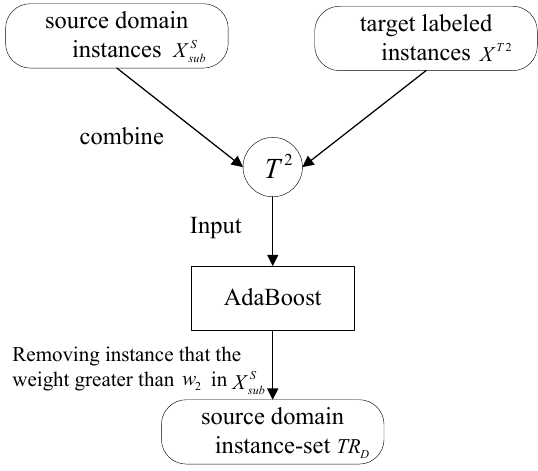
Figure 2. Framework of choosing the source domain instance-set.